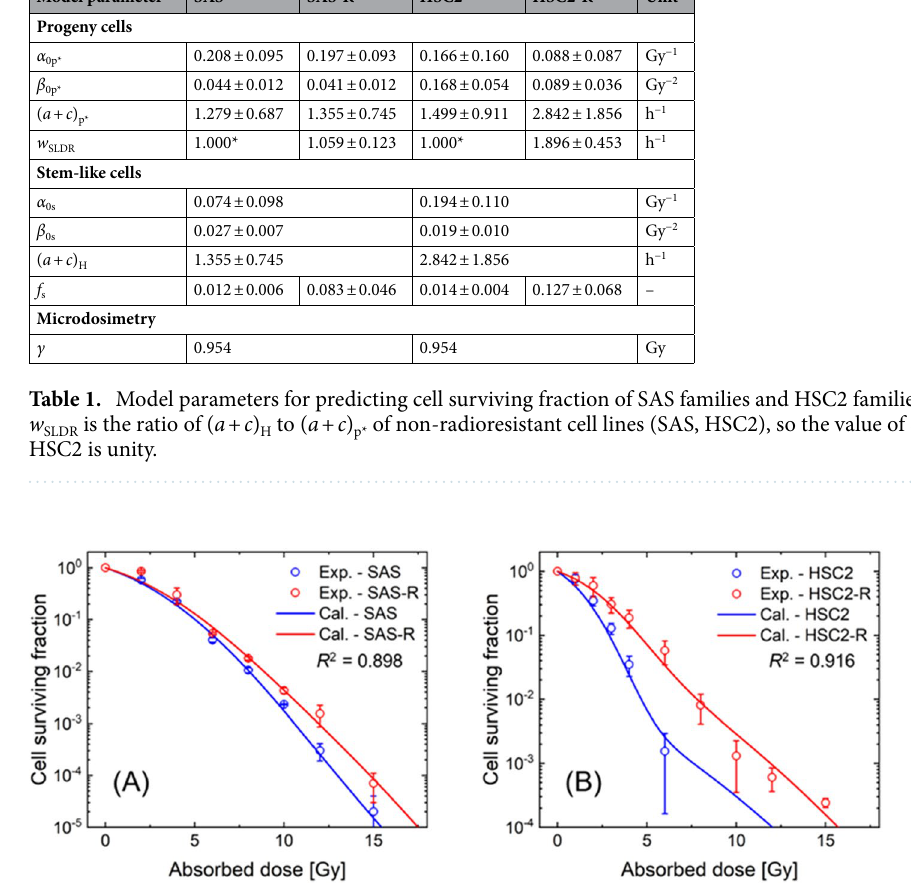
Figure 5. Cell surviving fraction of non-resistant and resistant cell lines after acute irradiation. ( A ) for SAS and SAS-R cell lines, and ( B ) for HSC2 and HSC2-R cell lines. The blue and red circle plots are the mean value of the experimental survival fraction of the non-resistant cells and resistant cells, respectively. The blue and red solid lines are the surviving fraction estimated by the IMK model considering the changes of CSCs fraction and SLDR